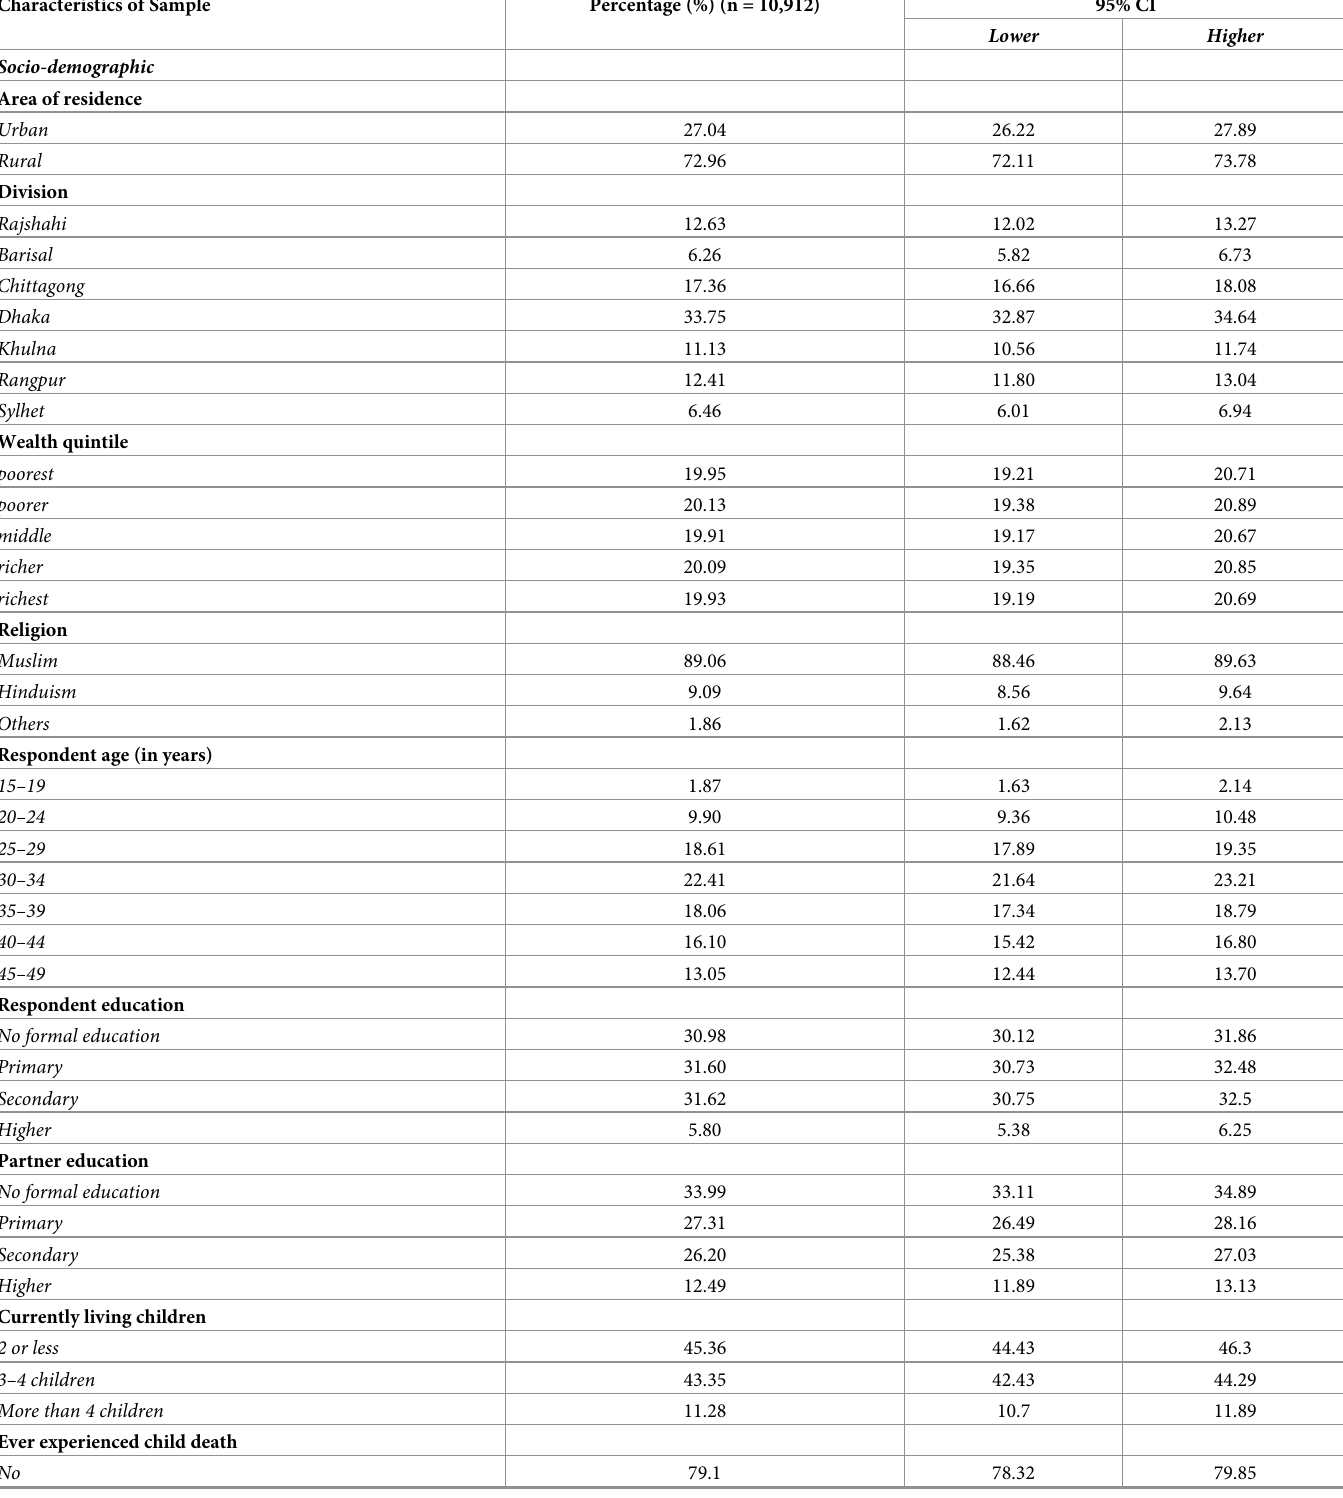
Table 1. Percentage distribution of study participants by demographic and empowerment characteristics (n = 10,912). Characteristics of